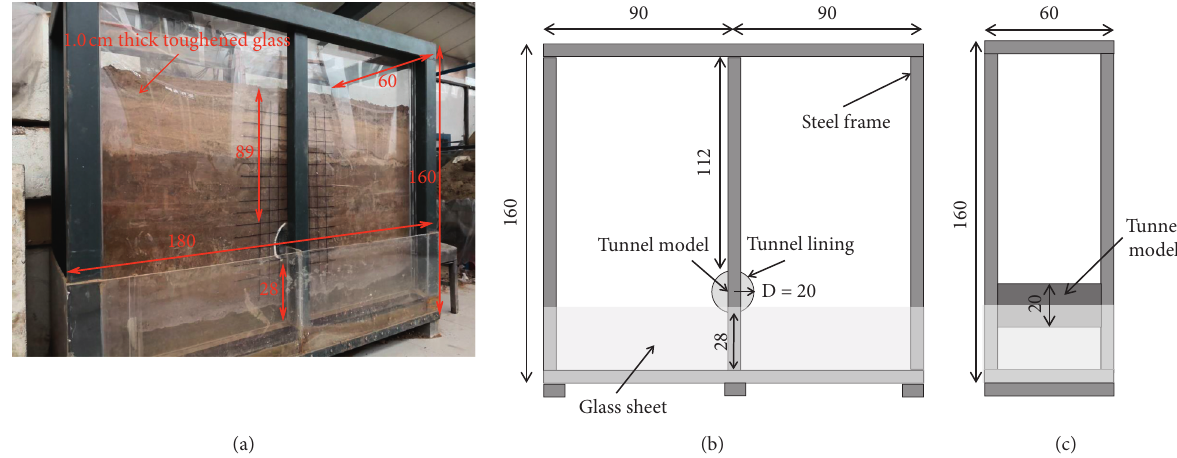
Figure 4: Model test chamber (unit:cm). (a) Actual image. (b) Front view. (c) Side view.